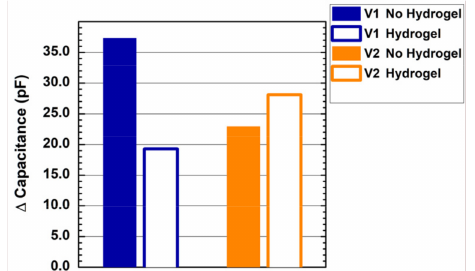
Figure 5. Changes in measured capacitance induced by contact between the sensing electrode and the forearm of a healthy volunteer with the probe V1 (blue histograms) and V2 (orange histograms). Full/hollow bars report results without/with a hydrogel layer on the capacitive sensor surface.